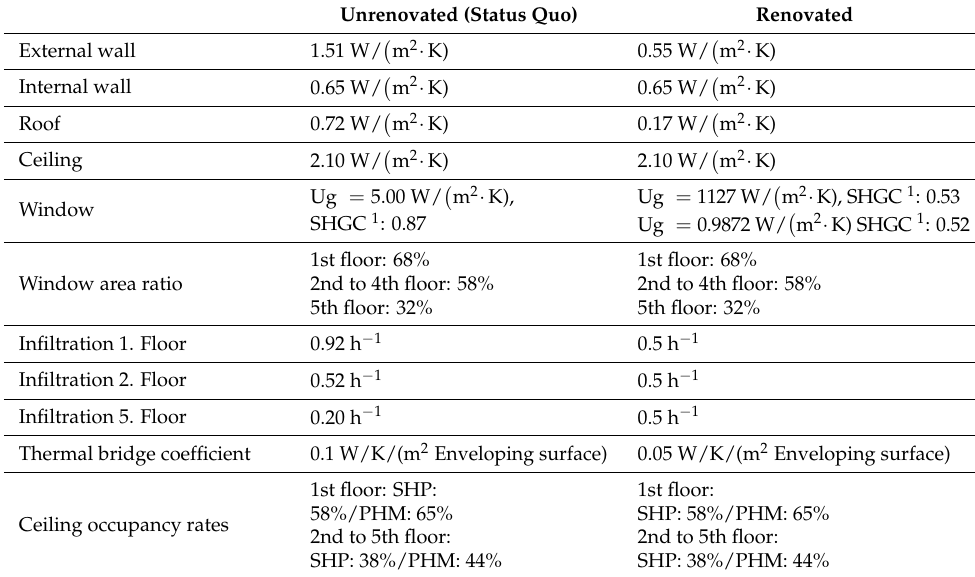
Table 1. Boundary conditions of the simulation